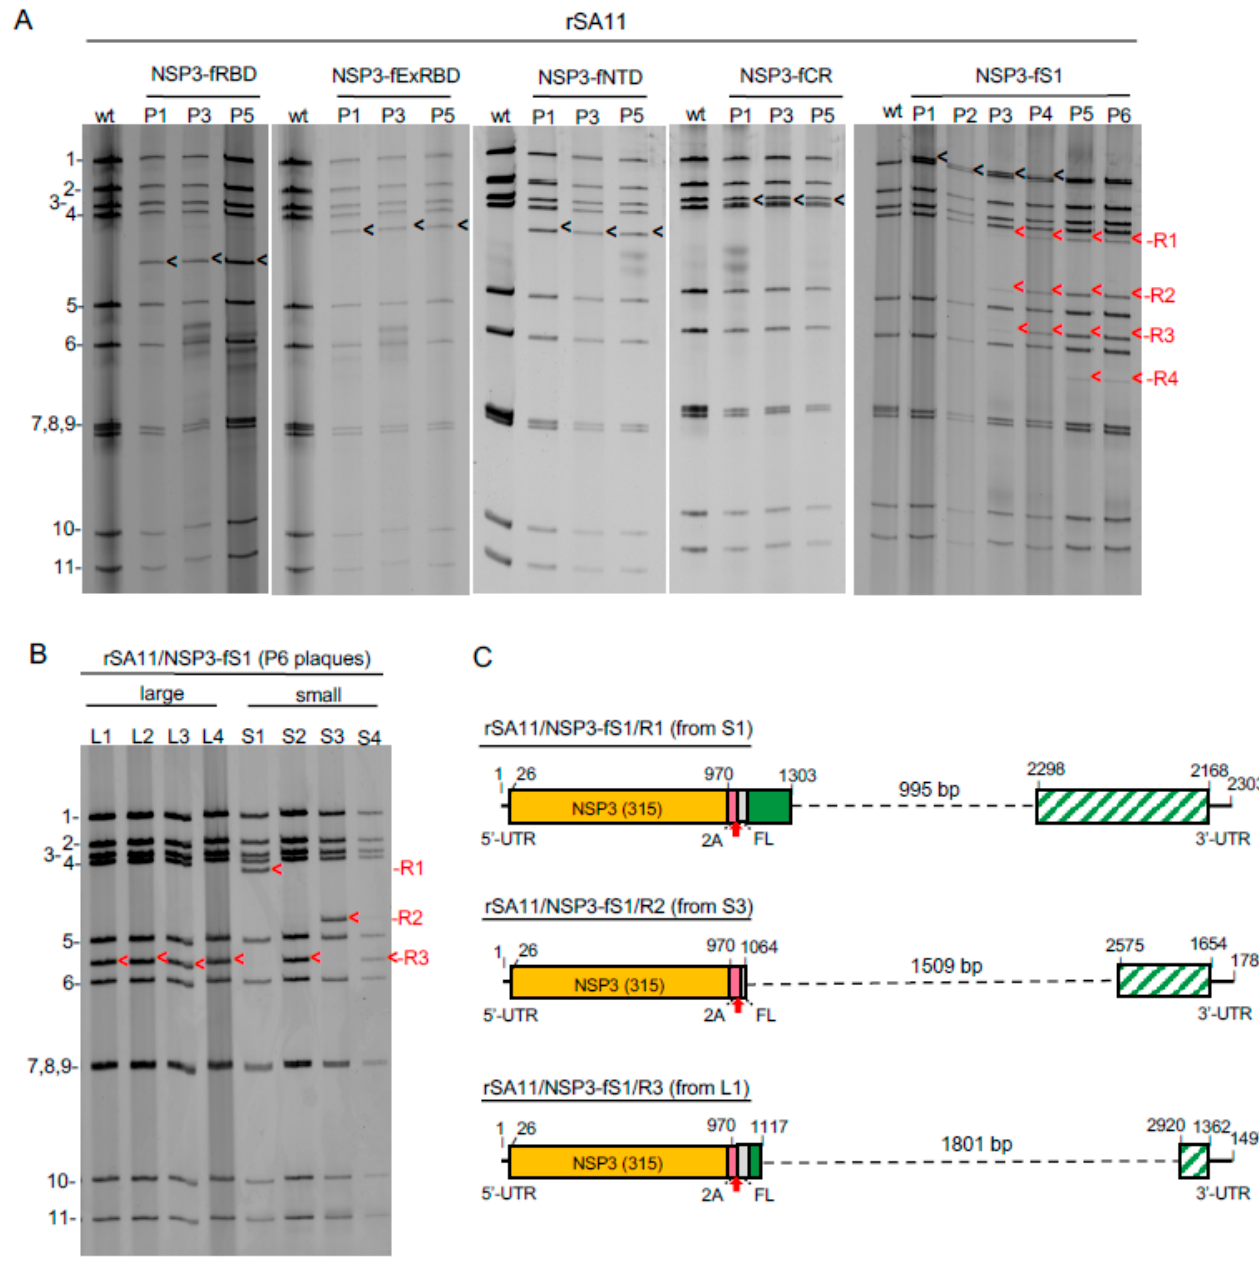
Figure 7. Genetic stability of rSA11 strains expressing SARS-CoV-2 S domains. rSA11 strains were serially passaged five to six times (P1 to P5 or P6) in MA104 cells. ( A ) Genomic RNAs were recovered from infected cell lysates and analyzed by gel electrophoresis. Positions of viral genome segments are labeled. Position of modified segment 7 (NSP3) dsRNAs introduced into rSA11 strains are denoted with black arrows. Genetic instability of the modified segment 7 (NSP3) dsRNA of rSA11/NSP3-fS1 yielded R1-R4 RNAs during serial passage. ( B ) Genomic RNAs prepared from large (L1–L4) and small (S1–S4) plaque isolates of P6 rSA11/NSP3-fS1. Segment 7 RNAs are identified as R1–R3, as in ( A ). ( C ) Organization of R1–R3 sequences determined by sequencing of segment 7 RNAs of L1, S1, and S3 plaque isolates. Sequence deletions are indicated with dashed lines. Regions of the S1 ORF that are no longer encoded by the R1–R3 segment 7 RNAs are indicated by slashed green-white boxes.